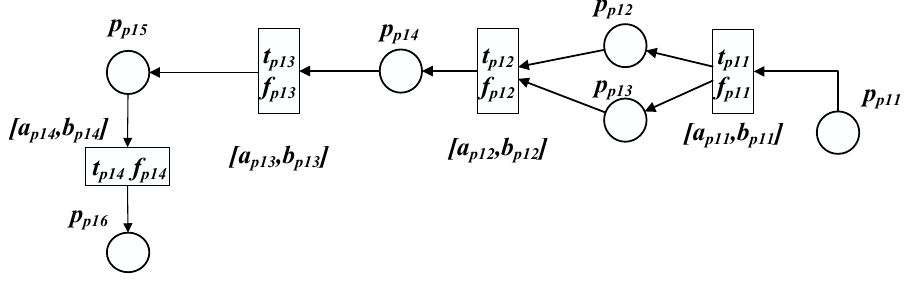
Figure 4. The subnet model N 1 .